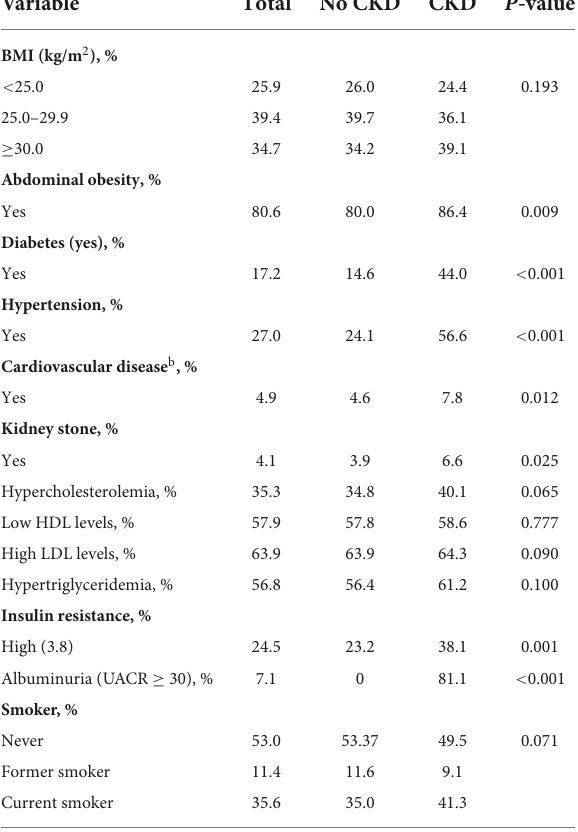
TABLE 2 Prevalence of comorbidities stratified by CKD in the study population. Variable